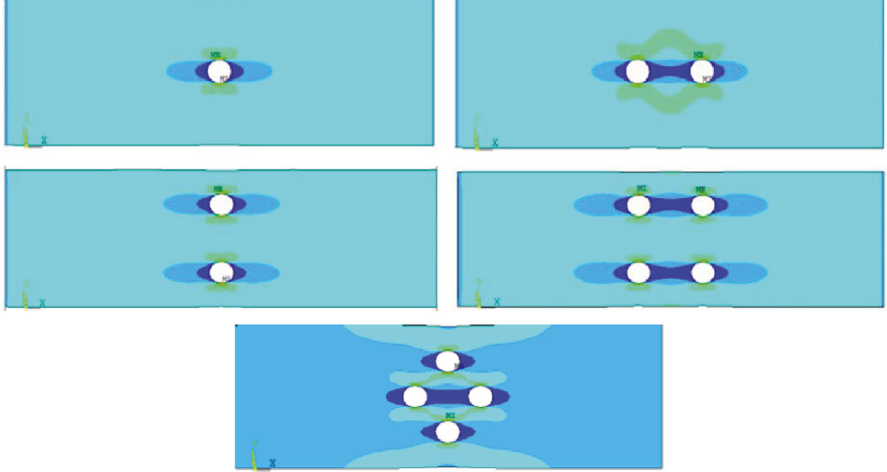
Figure 6: Stress contour around the hole [10].